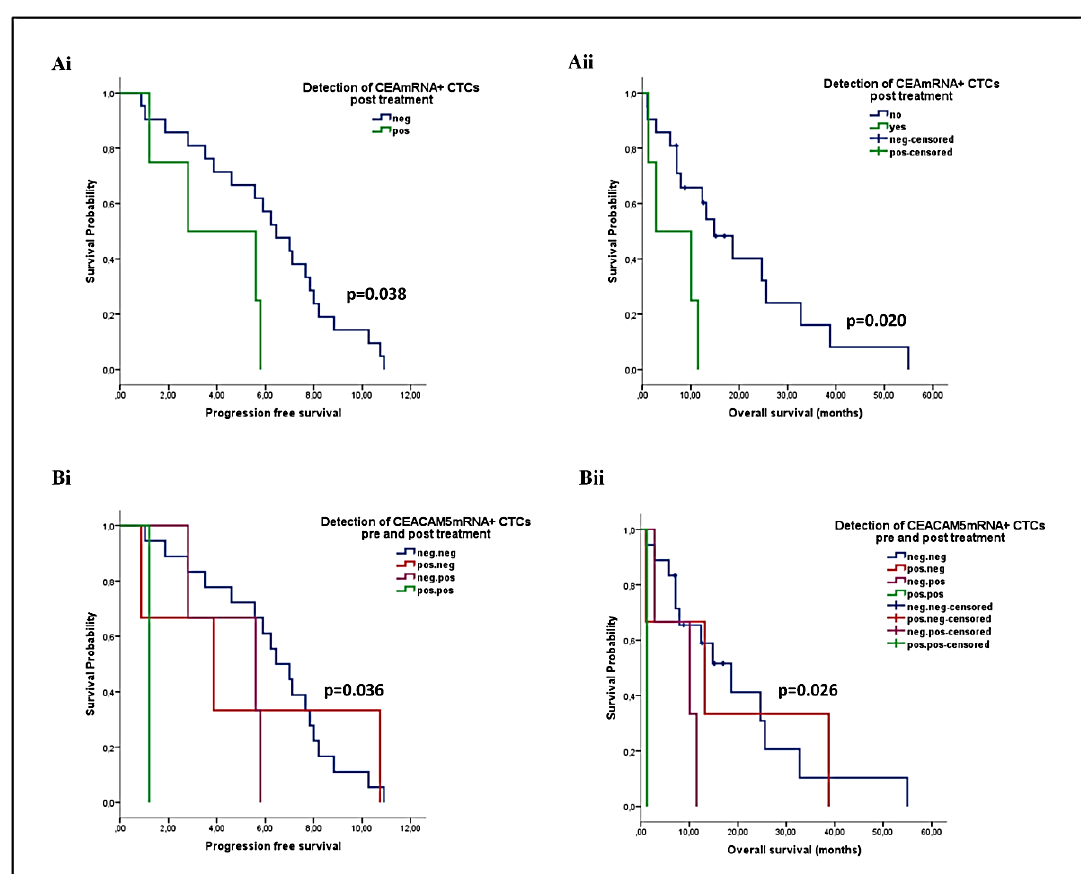
Figure 6. Prognostic relevance of the kinetics of CEACAM5 mRNA+ CTCs detected by RT-PCR during first-line chemotherapy in patients with advanced NSCLC ( Ai , Aii ) PFS and OS rates according to the CTC status at the end of treatment, ( Bi, Bii ) PFS and OS rates according to the combined CTC status pre- and post-treatment.